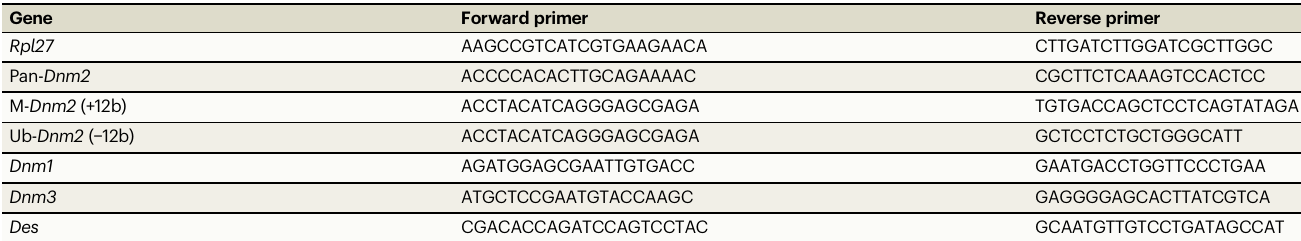
Table 1 | List of primers used for RT-qPCR